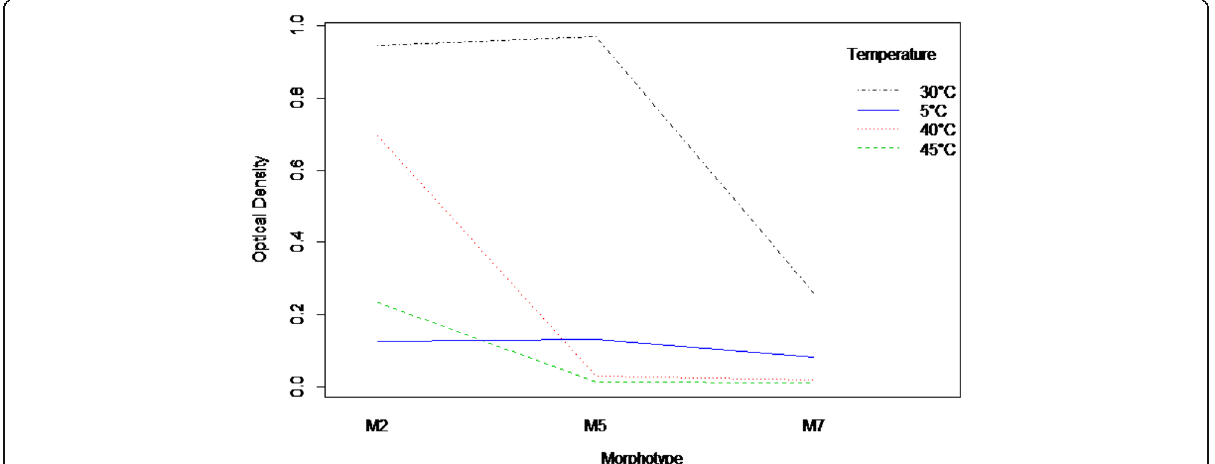
Fig. 3 Growth of antagonistic yeast morphotypes: M2, M5 and M7, under different temperatures. Growth was measured by optical density at 540 nm after 48 h under the evaluated temperature. The two-way ANOVA indicated highly significant effects for temperature ( F = 81.59; P < 0.05; df = 3) and morphotype ( F = 51.37; P < 0.05; df = 2) and a highly significant interaction effect ( F = 16.99; P < 0.05; df = 6)